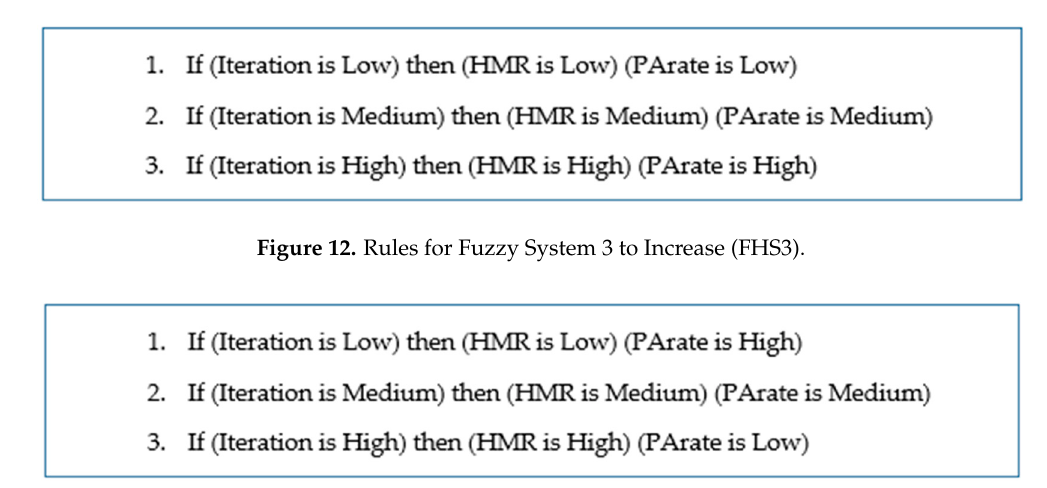
Figure 11. Rules for Fuzzy System 2 to Decrease (FHS2).